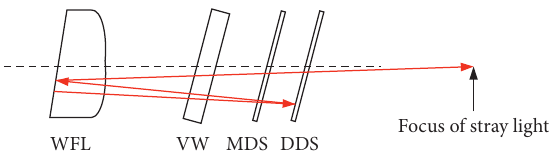
Figure 5: The result of high-order stray light.